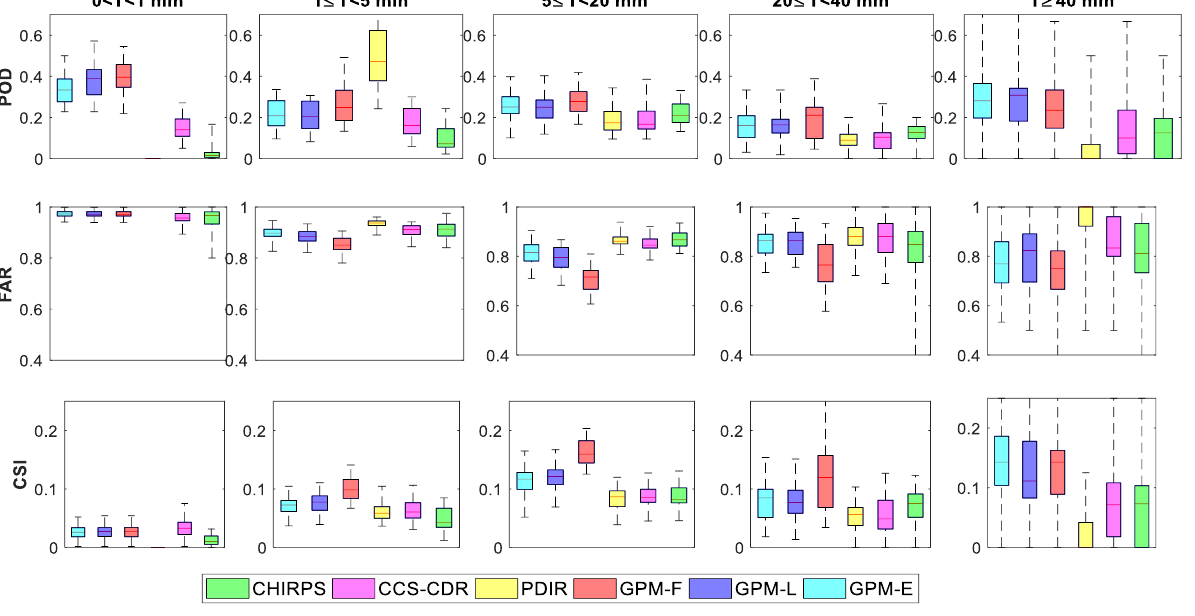
Figure 8. Boxplot of categorical metrics for five different intensity classes.